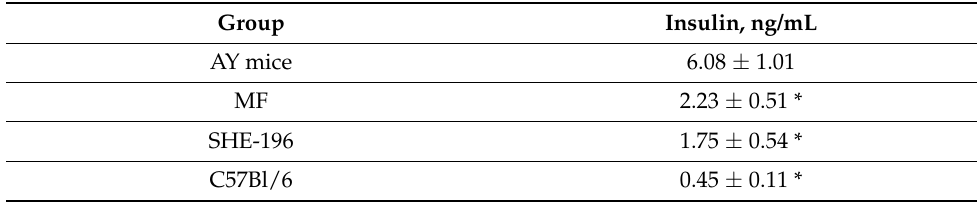
Table 2. Fasted insulin levels in AY mice treated for three weeks by SHE-196 at a dose of 15 mg/kg and MF at a dose of 250 mg/kg.